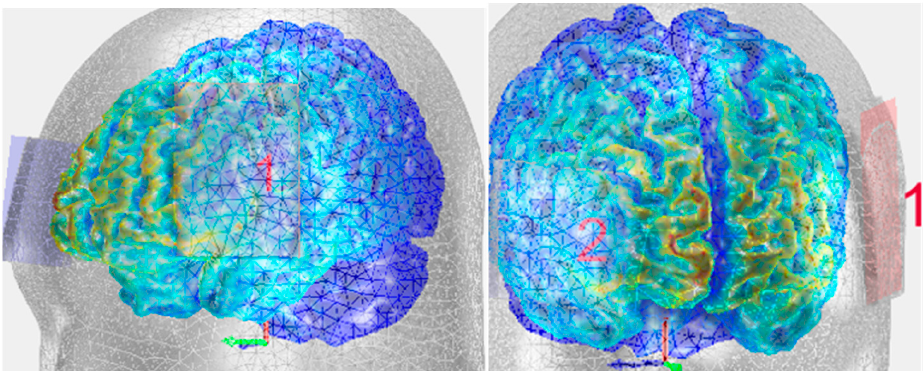
Figure 2. The current distribution in the brain with the anode (1) placed over the left Broca Area (F7) and the cathode (2) placed over the right inferior frontolateral gyrus (AF8).